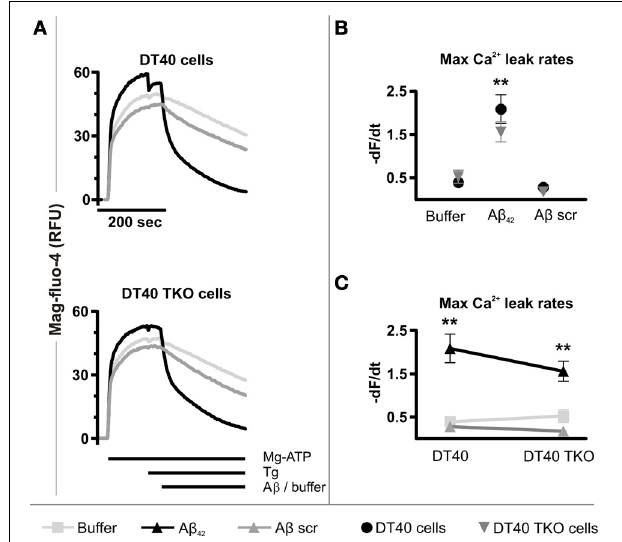
FIGURE 6 | A β 42 oligomers stimulate Ca 2 + release from the ER of permeabilized cells. (A) Representative traces of mag-fluo-4 fluorescence (relative fluorescence units, RFU) in permeabilized DT40 cells and DT40 TKO cells, illustrating changes in ER luminal Ca 2 + levels as a function of time in response to A β 42 oligomers, A β scramble and buffer alone. Data represents the mean of three measurements. (B,C) Initial quantitative analysis of the maximum Ca 2 + leak rates from the ER of permeabilized DT40 cells and DT40 TKO cells triggered by A β 42 oligomers, A β scramble and buffer, respectively. The maximal Ca 2 + leak rate was calculated by taking the maximal value of the first derivative of the fluorescence values to the time. Data were calculated as − dF/dt and represents the mean Ca 2 + leak rate obtained from three measurements in RFU over time (RFU/s). ∗∗ p < 0 .